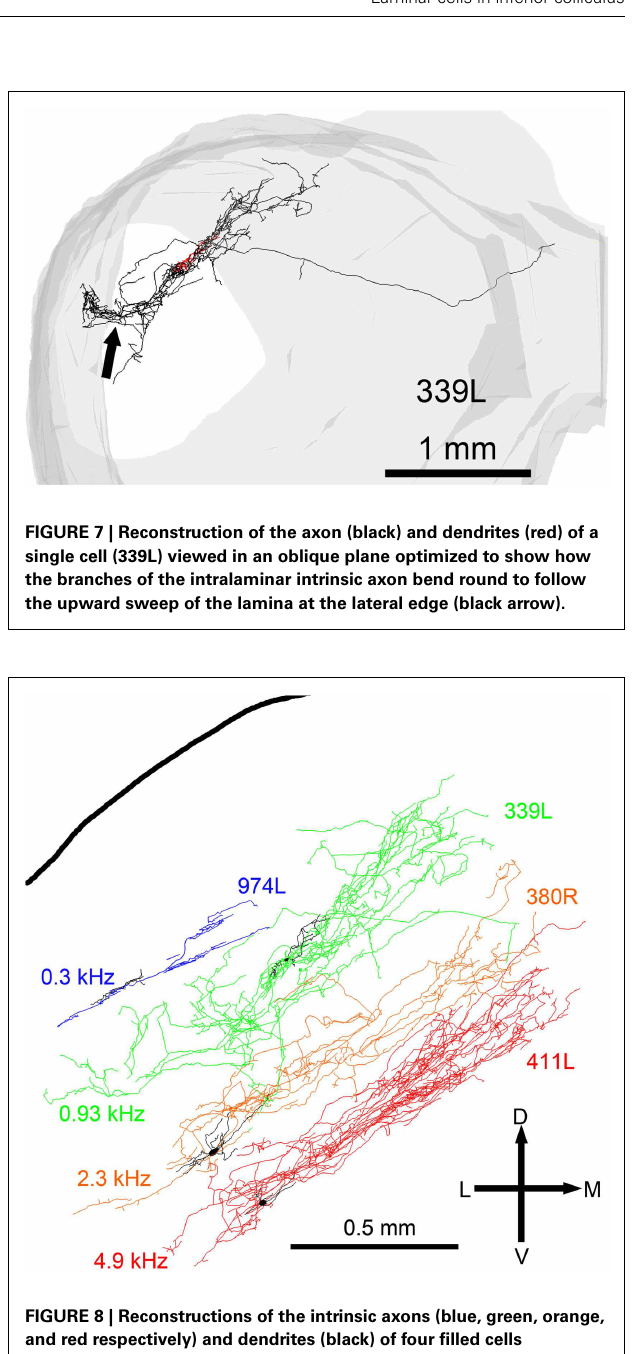
SPATIAL EXTENT OF INTRINSIC